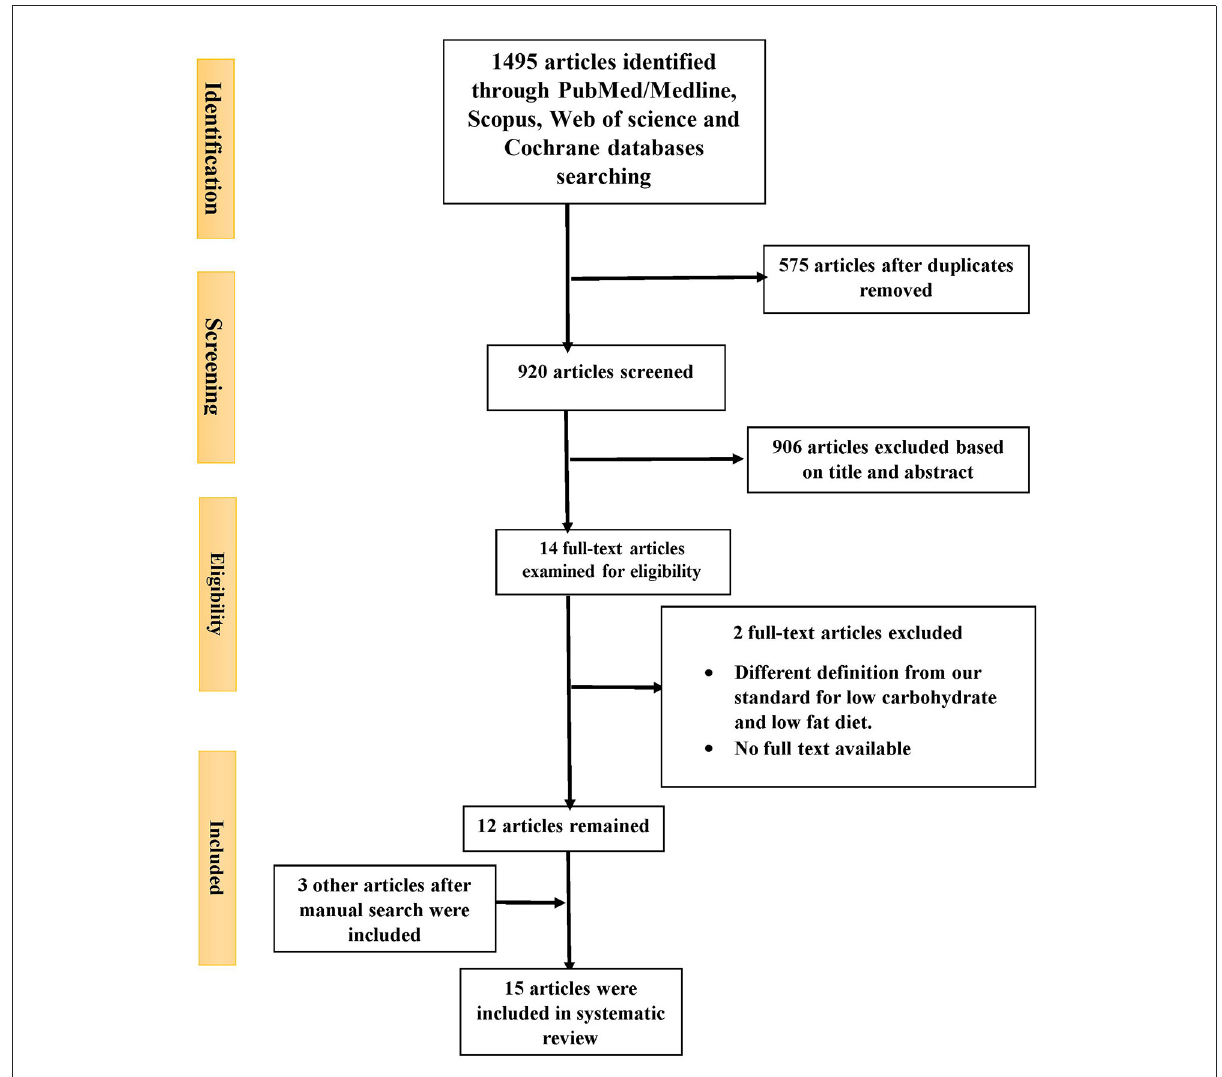
FIGURE1 PRISMA flowchart for study examined and included into the